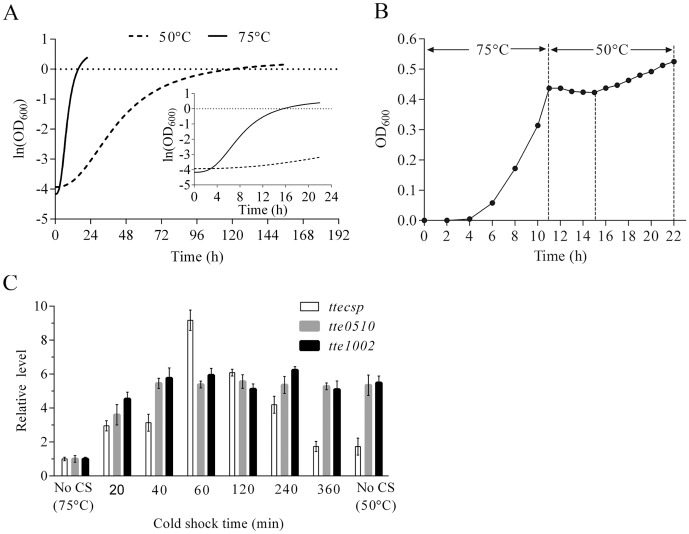
Cold shock response profile of T. tengcongensis.A. Growth profiles of separate cultures maintained at 75°C and 50°C. B. Growth profile following rapid temperature shift from 75° to 50°C. C. Transcription profiles of ttecspC, tte0510 and tte1002 following cold shock. Cells were grown at 75°C to an OD600 of 0.6, then cold shocked at 50°C for the indicated times. Control cultures (No CS) were grown constantly at 75° or 50°C. The data are shown as means ± SD (n = 3).